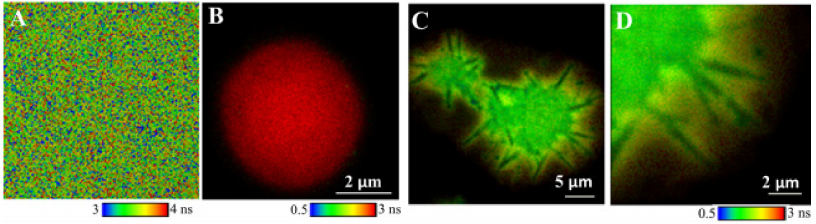
Figure 5. FLIM images of ( A ) TPPS in water (pH 3.0), ( B ) hollow (PAH/PSS) 2 PAH, and ( C ) core-shell CaCO 3 (PAH/PSS) 2 PAH PECs after TPPS adsorption (pH 3.0). ( D ) Magnification of C. λ exc = 483 nm. Adapted with permission from [90]. Copyright 2017 American Chemical